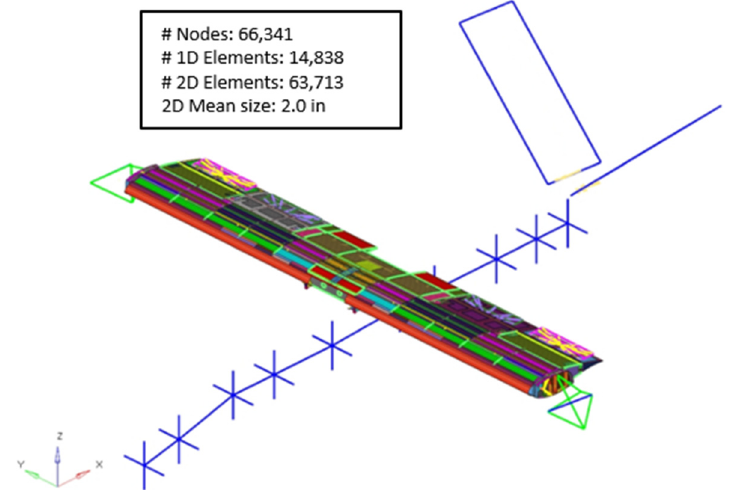
Figure 3. Global Finite Element Model (FEM).